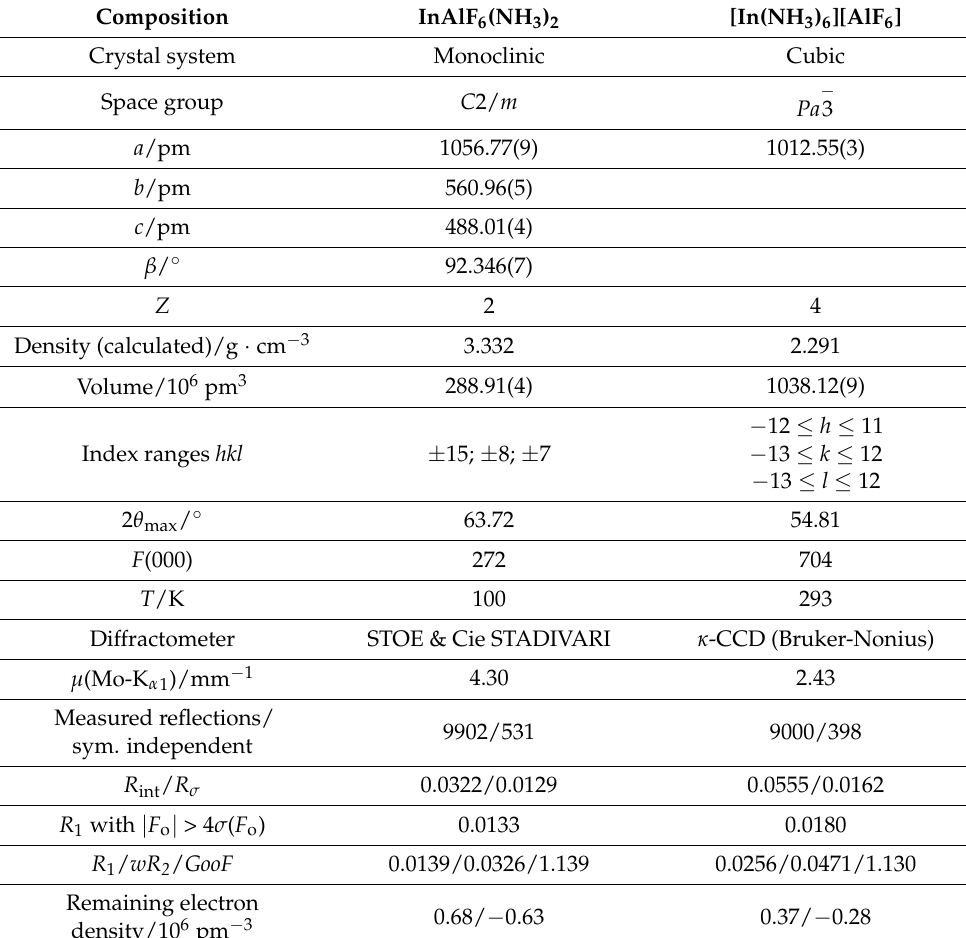
Selected crystallographic parameters and refinement data of all three compounds are presented in Tables 1 and 2. Table 1. Selected crystallographic parameters and refinement data of InAlF 6 (NH 3 ) 2 and [In(NH 3 ) 6 ][AlF 6 ].